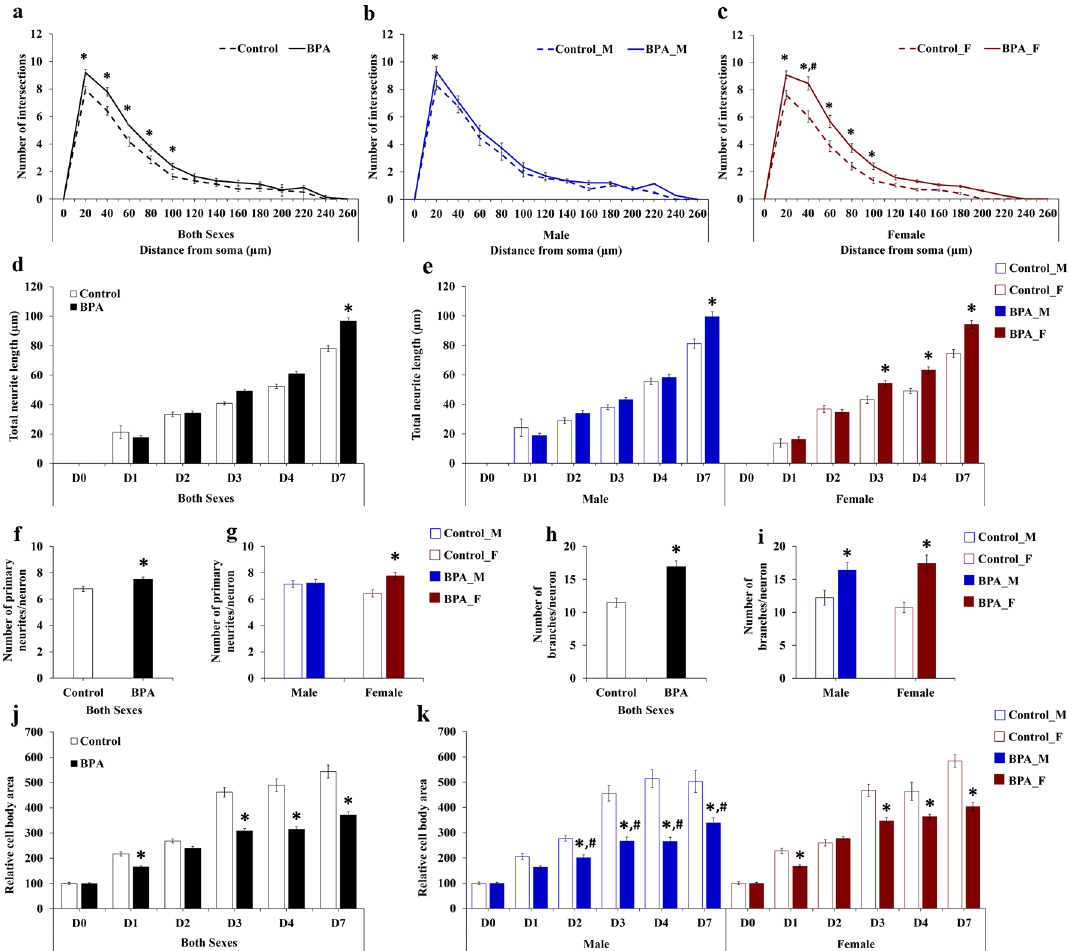
Figure 6. Quantification of neurite formation in primary hippocampal cells isolated from the hippocampus of the rat offspring prenatally exposed to BPA or vehicle control. Hippocampal cells were isolated from neonatal rat pups prenatally exposed to BPA or the vehicle control and cultured for 7 days. Images of the cells were taken using an inverted microscope. Sholl analysis ( a – c ) and evaluation of total neurite length ( d – e ), number of primary neurites and branching ( f – i ), and cell body area ( j – k ) were performed. Data are presented as the mean ± SEM. * ,# P value < 0.05. *Indicates a statistically significant difference between the BPA treatment and the vehicle control groups. # Indicates a statistically significant difference between males and females in the BPA group on the same